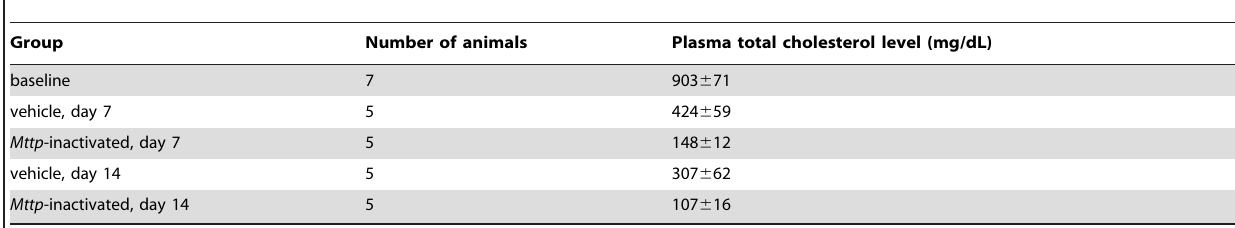
Table 1. Mttp inactivation lowers plasma cholesterol in the treatment vs. control groups.